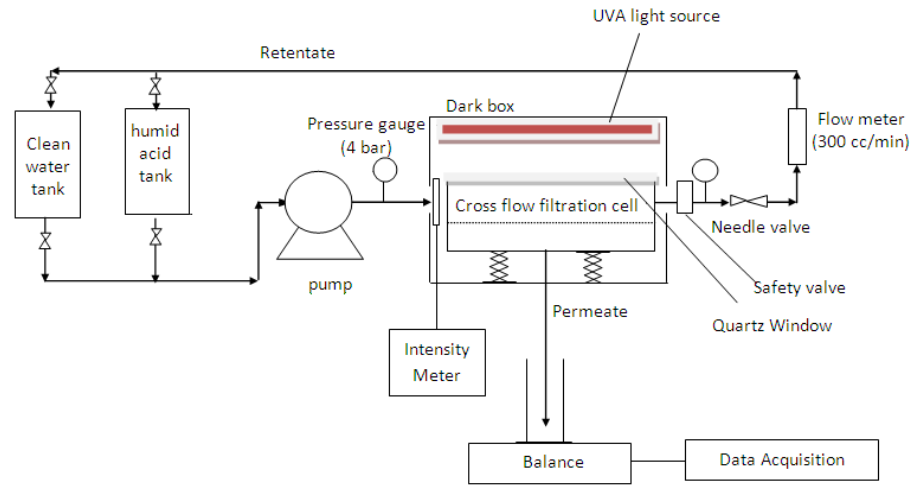
Figure 1. Schematic diagram of the laboratory bench scale cross-flow recirculation unit.